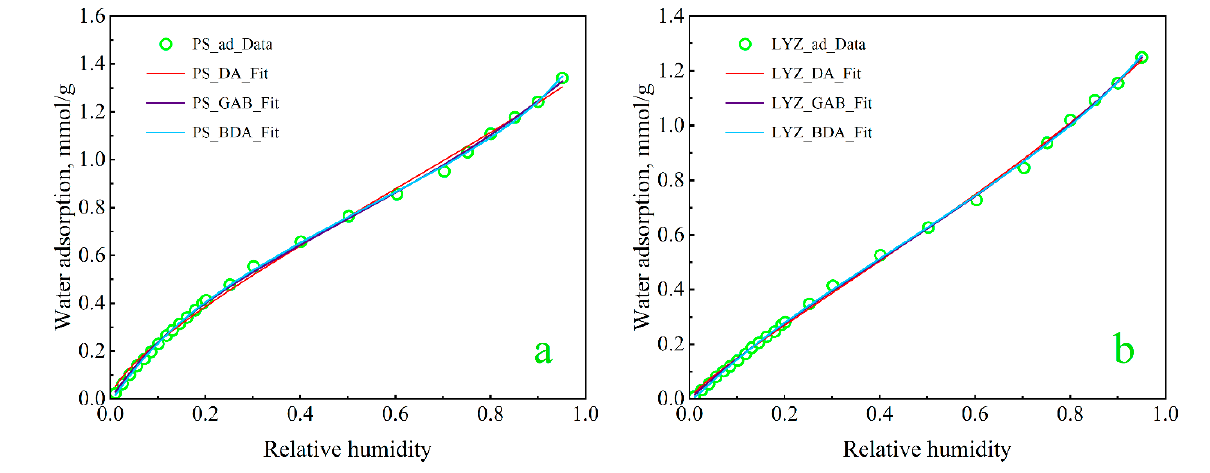
Figure 8. DA, GAB, and BDA model fitting curves for PS and LYZ coal sample’s adsorbed water vapor data. Table 4. DA, GAB, and BDA modeling parameters of adsorption isotherms of PS and LYZ coal samples.